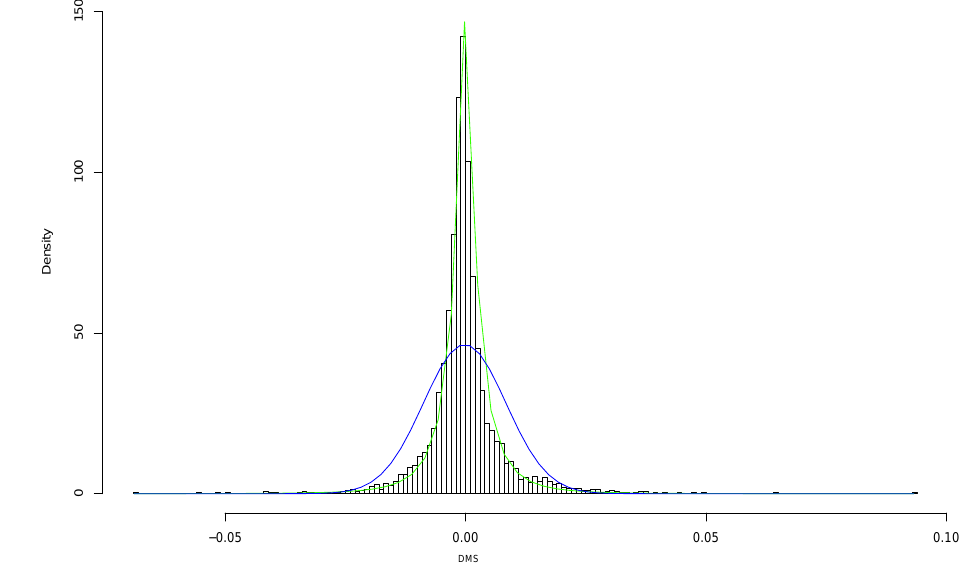
Figure 13. Distribution of the dependent variable DMS i , t , c with normal (blue) and two-sided lognormal (green)